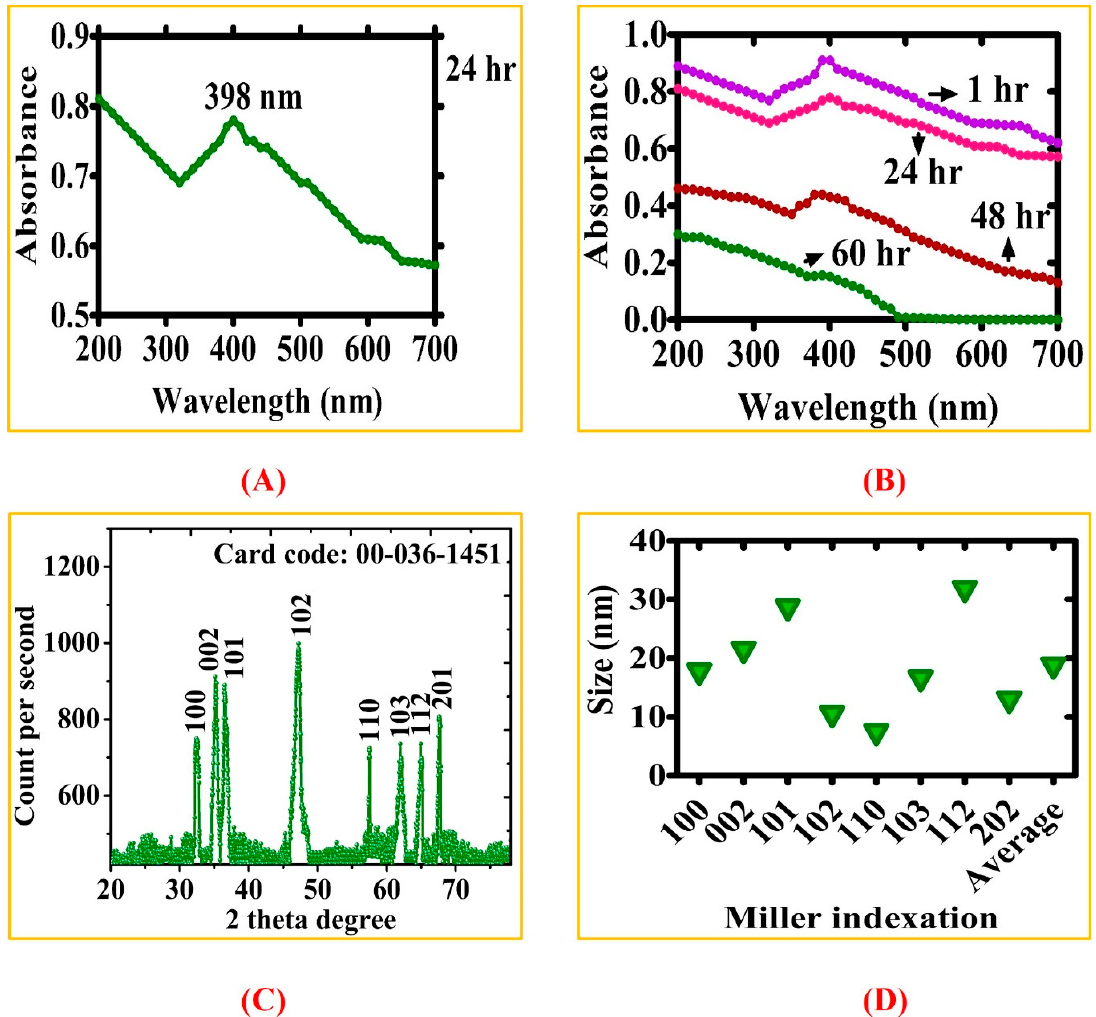
Figure 2. UV and XRD spectra analysis for biogenic ZnONPs ( A ) UV visible spectra ( B ) Stability of biosynthesized ZnONPs ( C ) XRD spectra of Geranium wallichianum mediated ZnONPs ( D ) Size calculation via Scherer approximation.